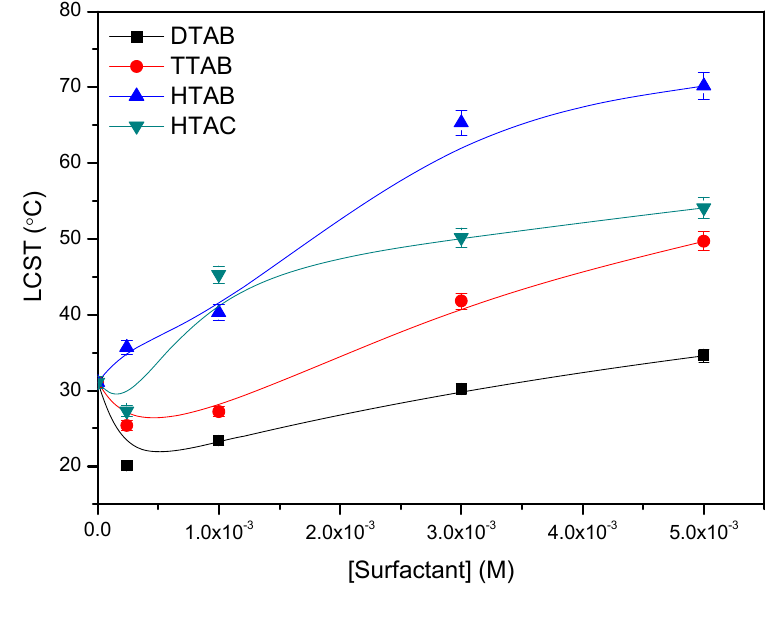
Figure 6. Effect of cationic surfactants on the LCST of copolymer BCP-1.